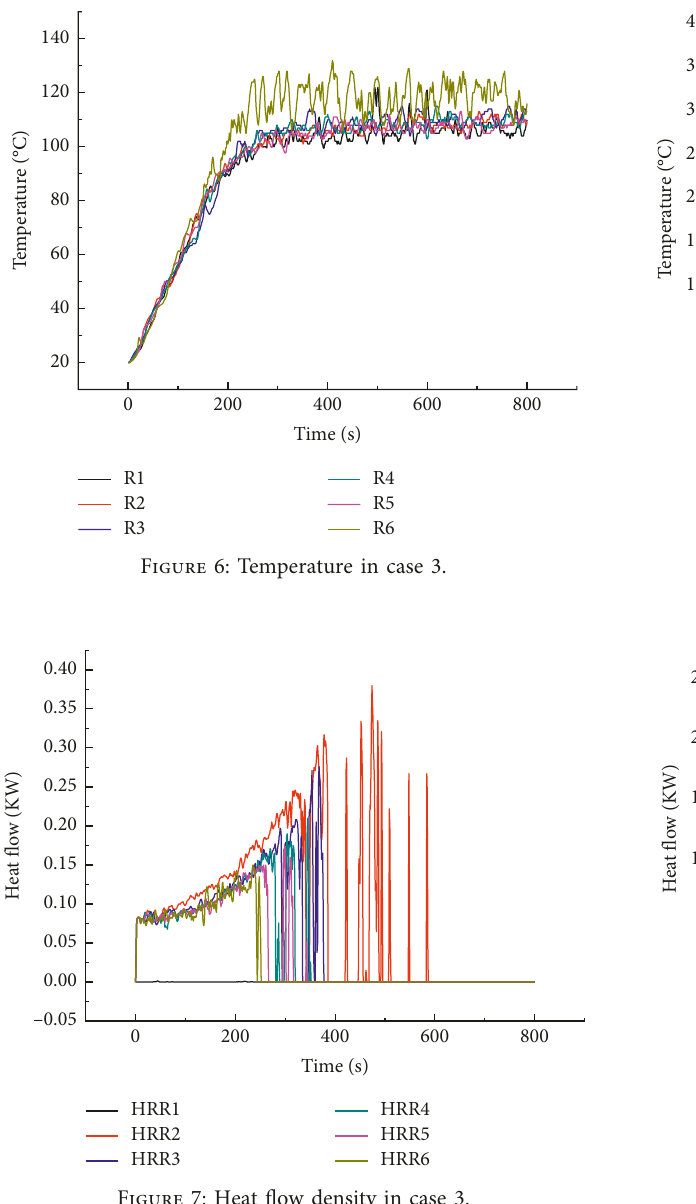
Figure 7: Heat flow density in case 3.